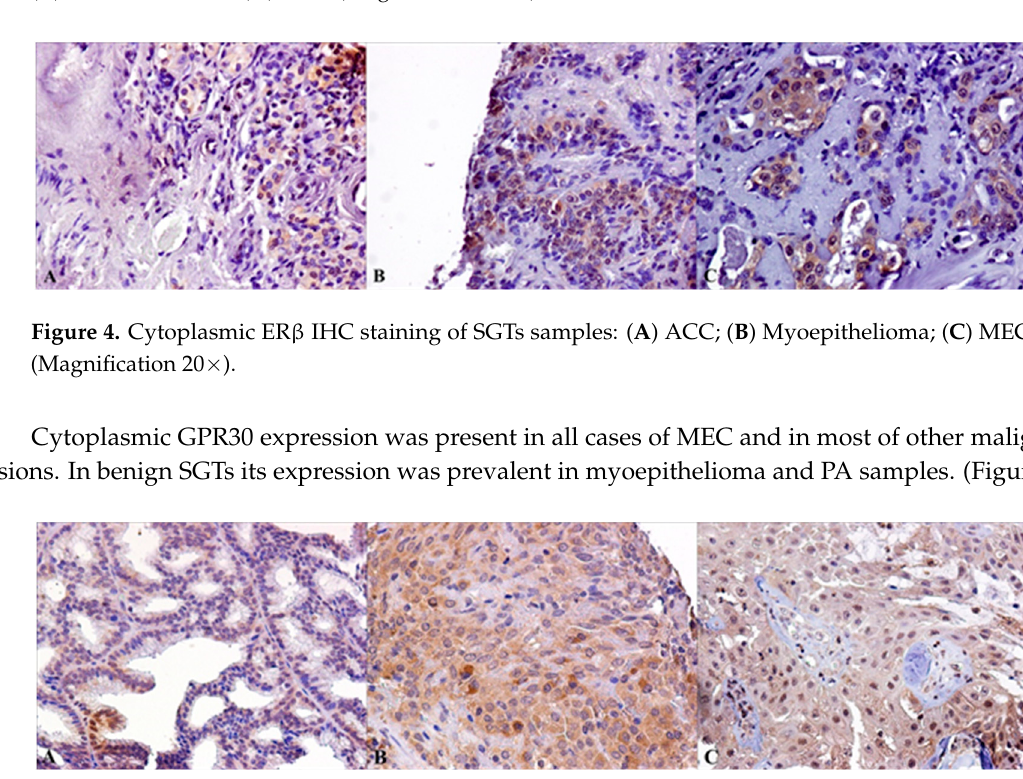
Figure 3. Nuclear ER β IHC staining of SGTs samples: ( A ) PA; ( B ) acinic cell carcinoma (ACC); ( C ) Warthin’s tumor; ( D ) MEC (Magnification 20×).